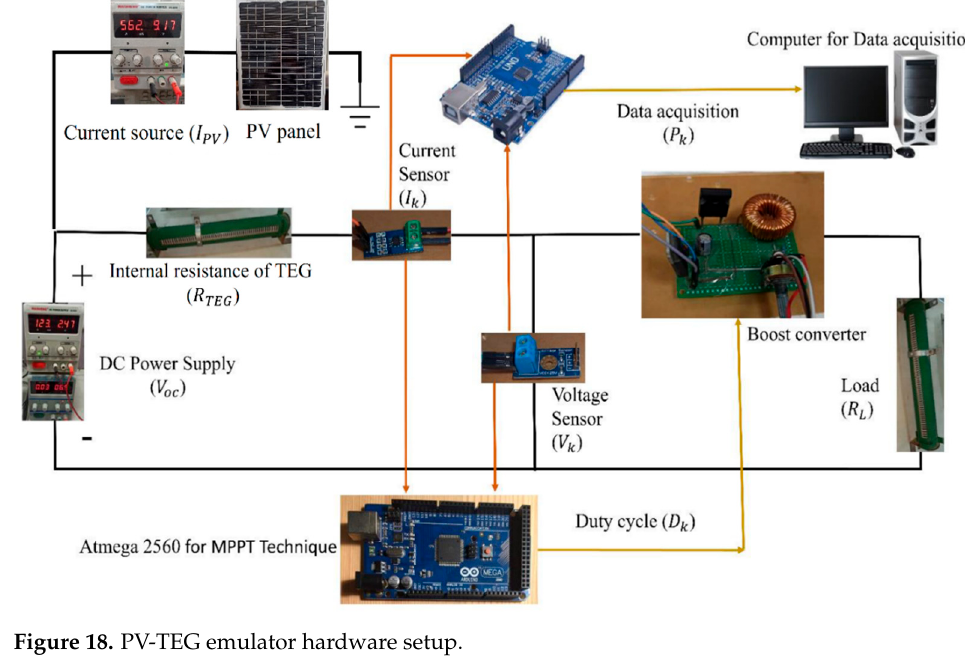
Figure 18. PV-TEG emulator hardware setup.